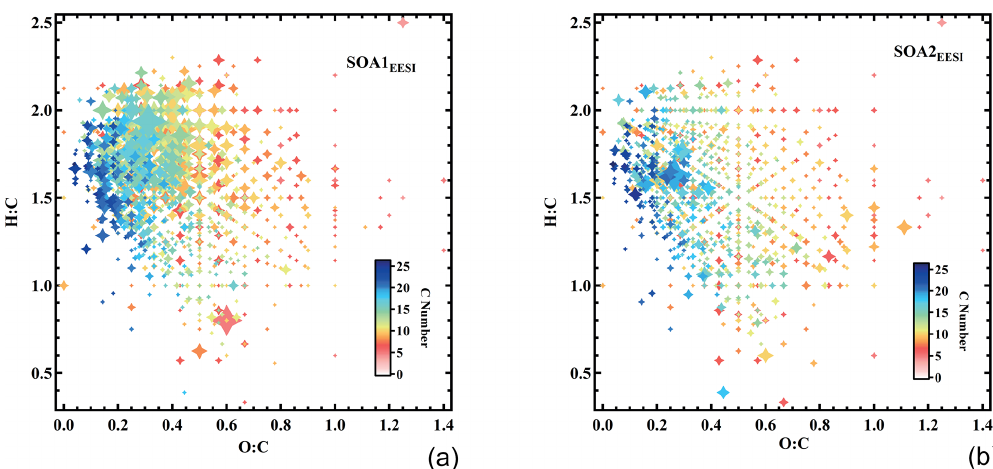
Figure 9. Van Krevelen plots (atomic H : C vs. O : C) for the SOA1 EESI and SOA2 EESI factor mass spectra. The points are sized by the fraction of each neutral compound apportioned to SOA1 EESI and SOA2 EESI and colored by the number of carbon